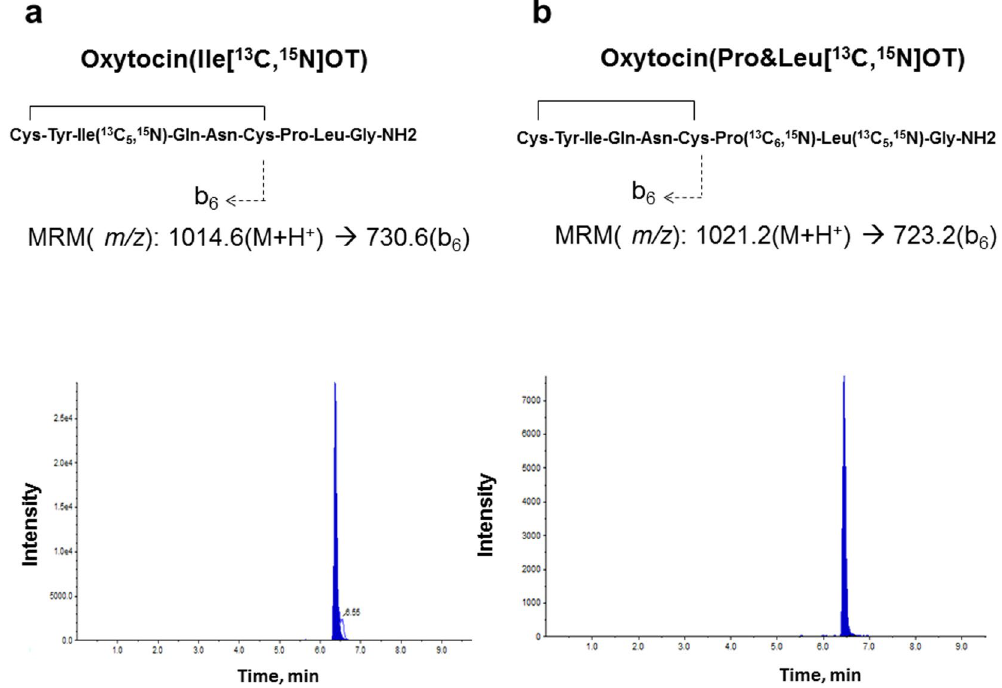
Figure 7. MS/MS fragmentation and MRM detection of the oxytocins Ile[ 13 C, 15 N]OT and Pro&Leu[ 13 C, 15 N] OT. The multiple-reaction monitoring MRM transitions of the two stable isotope-labelled OTs used in this study are shown. These parent ions [M + H + ] ( m/z 1014.6 and m/z 1021.2) produce the fragment (daughter) b6 ions ( m/z 730.6 and m/z 723.2) after collision with N 2 gas in the collision cell, and both b6 ions are then selectively detected. The representative MRM chromatograms (left and right) correspond to Ile[ 13 C, 15 N]OT and Pro&Leu[ 13 C, 15 N]OT in one of the four mouse plasma samples. [Pro&Leu 13 C, 15 N]OT (10 ng/mL) was spiked as an internal standard (I-STD) into all